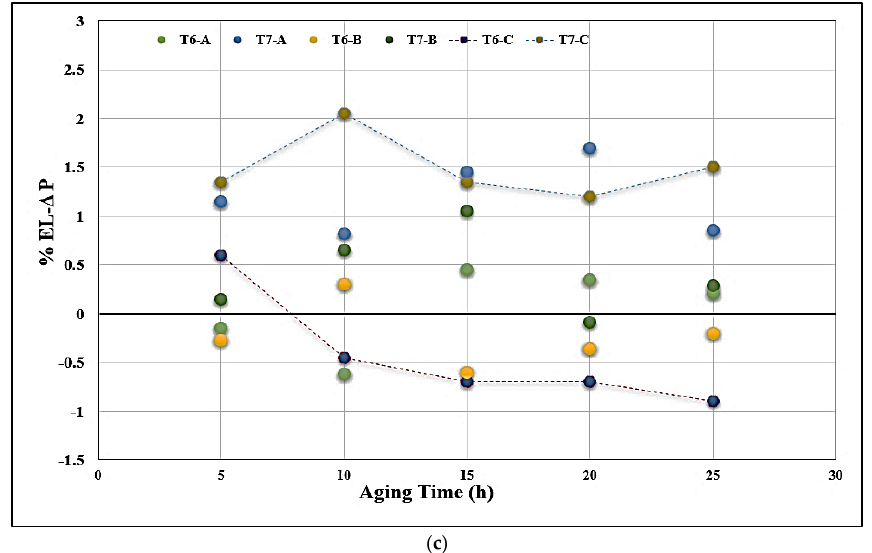
Figure 13. Contribution of Mg content and aging to the tensile properties of alloy A in the cast condition: ( a ) UTS, ( b ) YS, and ( c ) % El.